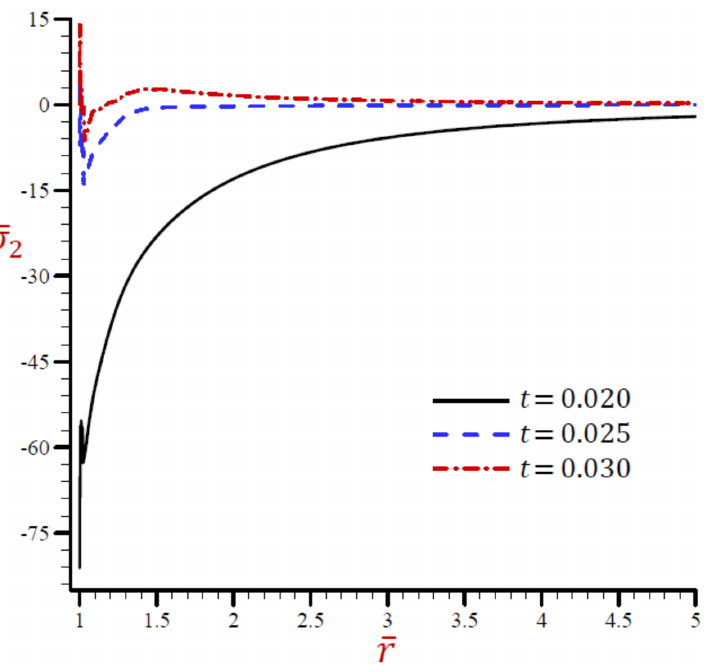
Figure 23. Effect of t on radial stress σ 2 across the radial direction of the cylindrical cavity utilizing the RDPL